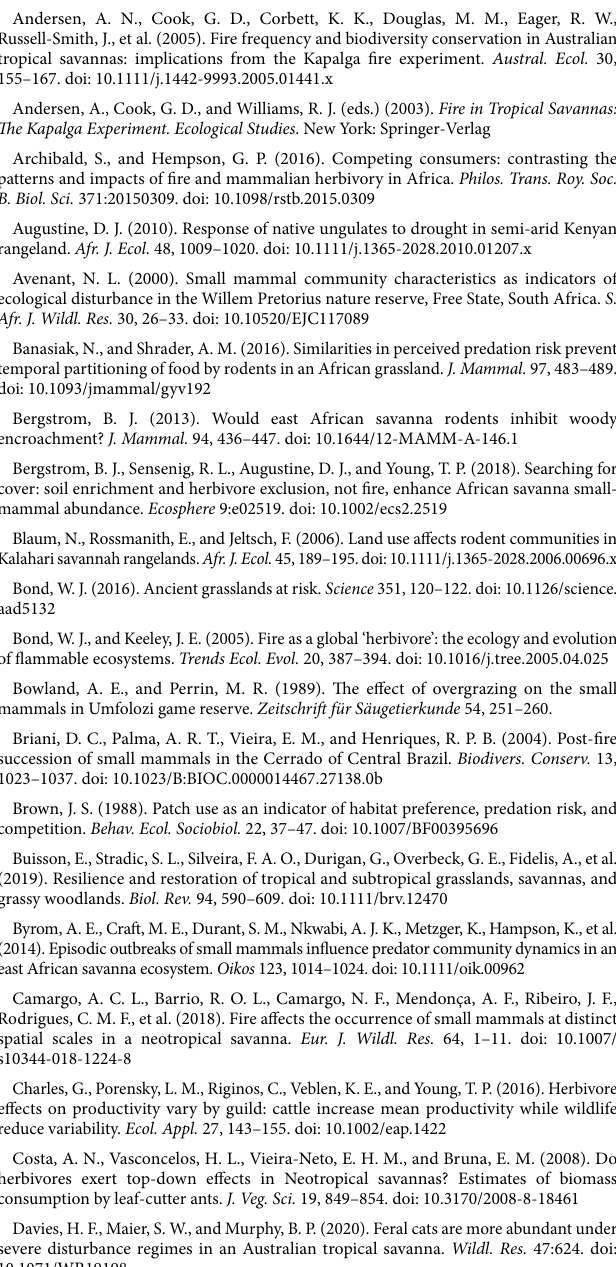
SUPPLEMENTARY TABLE S2 Bibliography on habitat responses of tropical savanna small-mammal communities, and related studies and sources, including other